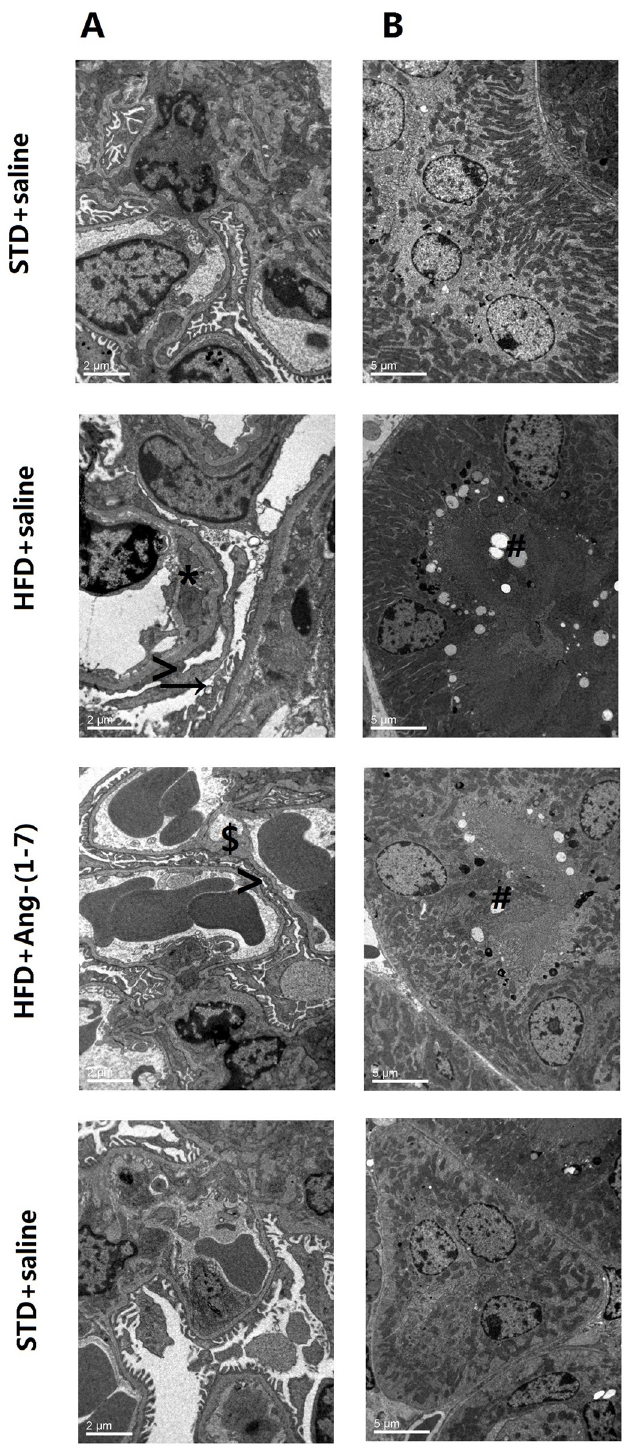
Fig 8. Findings of transmission electron microscopy analysis. Ang-(1 – 7) improves HFD-induced GBM injury and lipid droplet accumulation in tubules. Photographs of podocyte fusion ( > ), mesangial cell cytoplasm insert in GBM ( * ), podocytes absorbing lipid droplets ( ! ), lipid droplet accumulation in tubules (#), thickening of GBM ($) from all Groups. A: Glomeruli (magnification 4000×) B: tubules (magnification